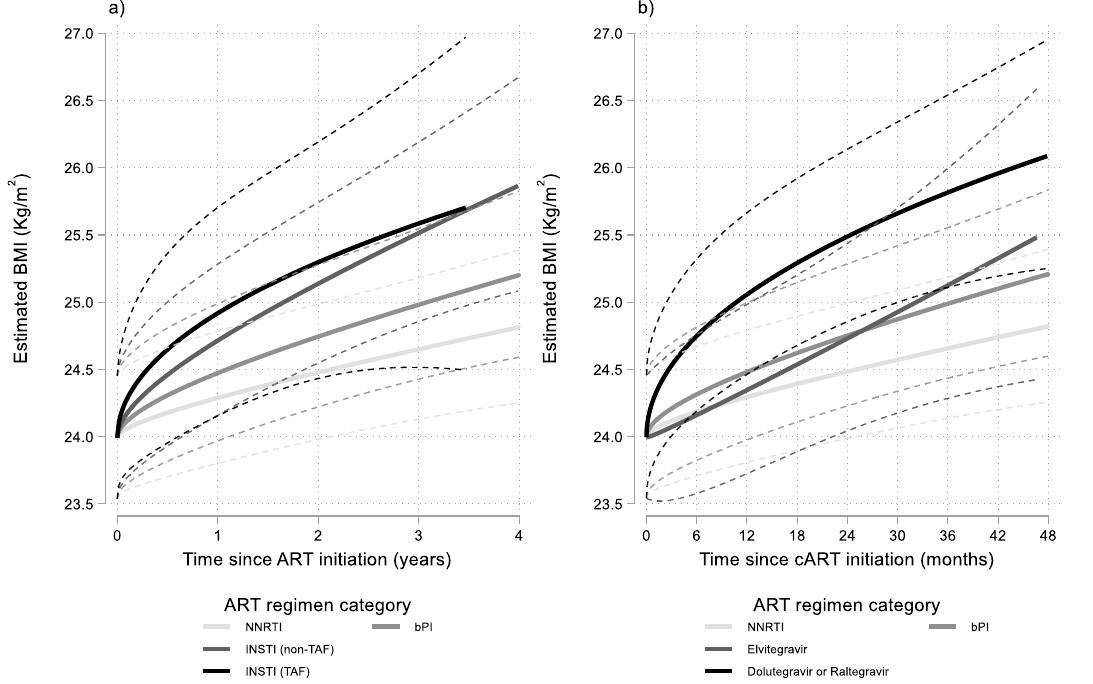
Figure 2. Results from multivariable linear mixed model: estimated BMI (95% CI) after cART initiation by time since ART initiation and ART regimen category. Estimates shown for men having sex with men (MSM), aged 30–39, with no AIDS and with 10,000–49,999 HIV-RNA copies/mL at baseline. INSTI regimens stratified into: ( a ) containing or not containing TAF and ( b ) using Elvitegravir or using Dolutegravir or